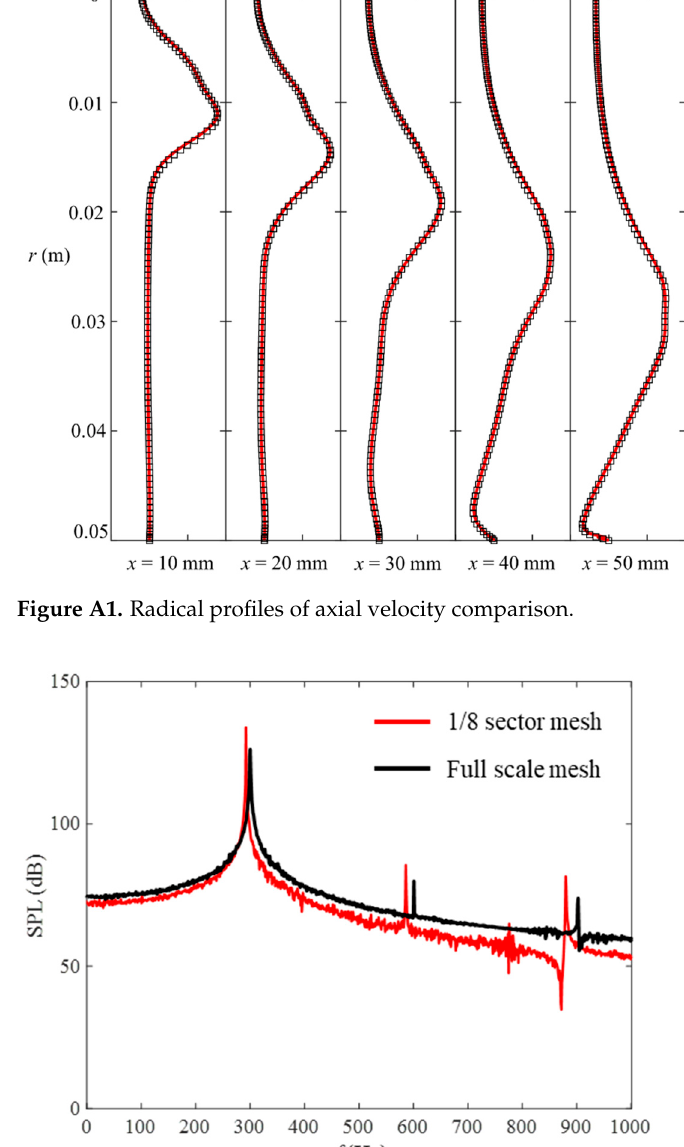
Figure A2. Frequency spectrum comparison.